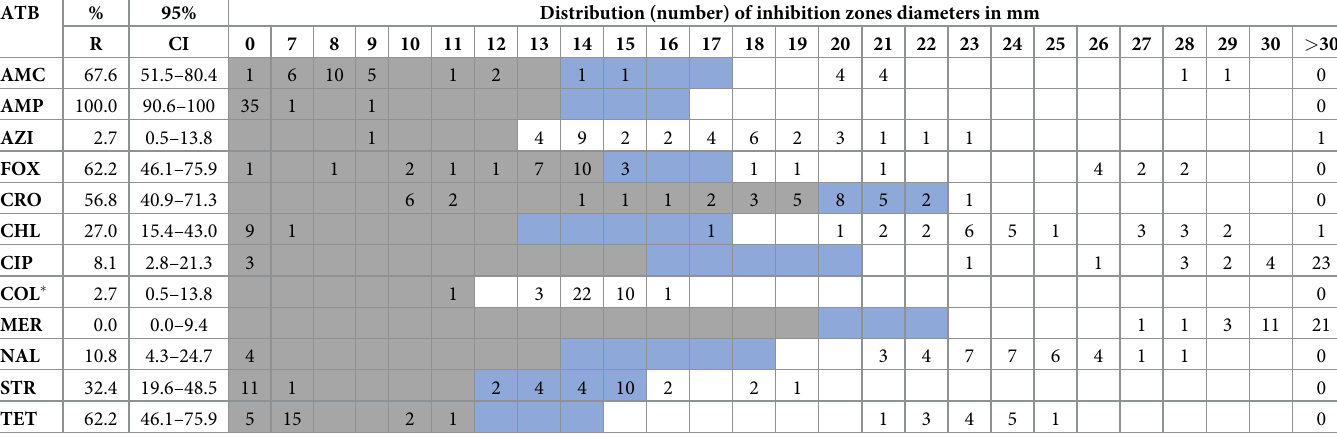
Table 3. Distribution of inhibition zone diameters of presumptive third-generation cephalosporin resistant E . coli (n = 37) isolated on MacConkey agar supple- mented with 1 μ g/mL cefotaxime. ATB % 95% Distribution (number) of inhibition zones diameters in mm